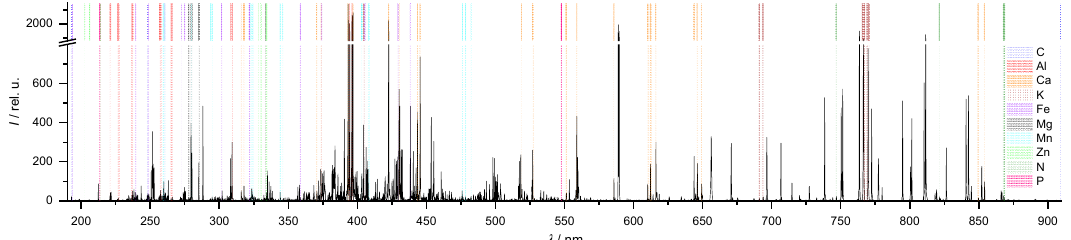
Figure 1. Representative laser-induced breakdown spectroscopy (LIBS) spectrum of a soil sample of the field near Wilmersdorf, lines of the elements investigated are marked by colored lines (labels on the right).